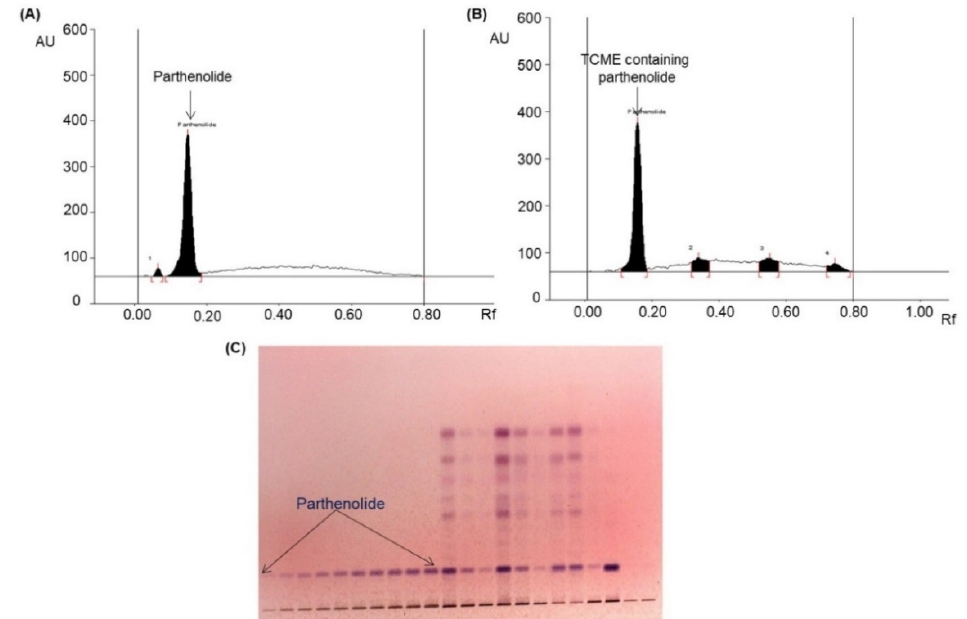
Figure 3. Quantification of parthenolide in BBD-run TCME sample by HPTLC [mobile phase– n -hexane:ethyl acetate (3:1, v / v ); λ max = 575 nm]. ( A ) Chromatogram of standard parthenolide (R f = 0.16); ( B ) chromatogram of the TCME sample (parthenolide, spot 1, R f = 0.16); ( C ) pictogram of TLC plate derivatized with p -anisaldehyde in daylight.